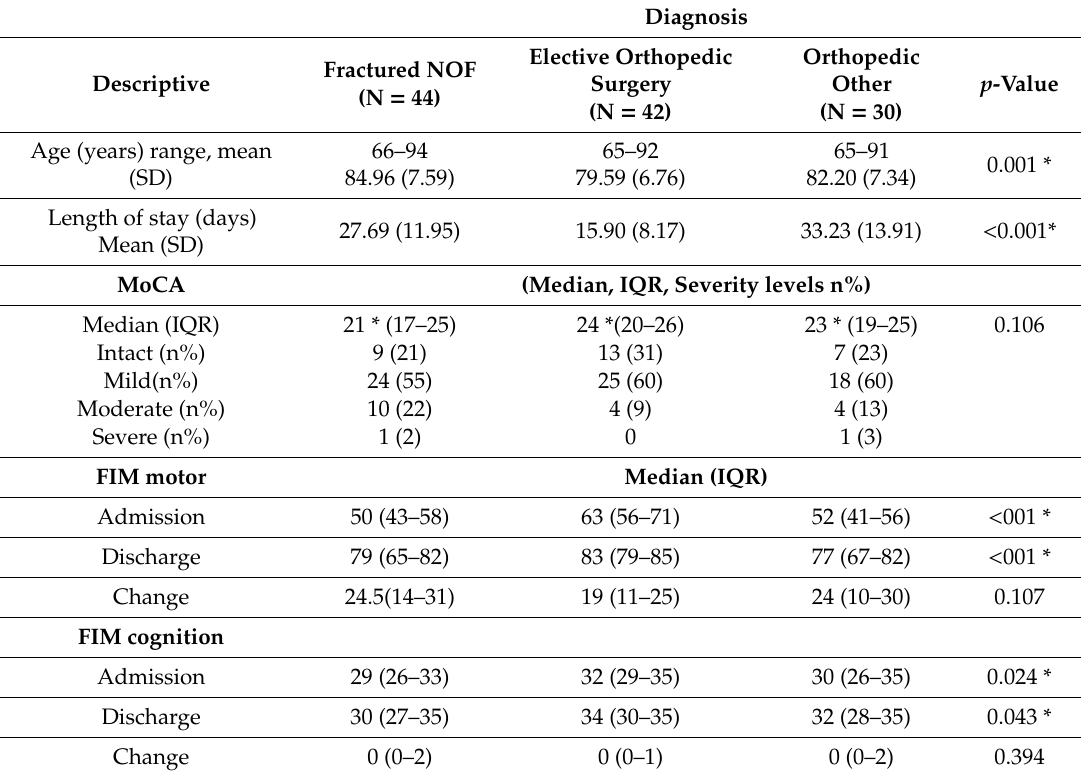
Table 2. Clinical characteristics based on